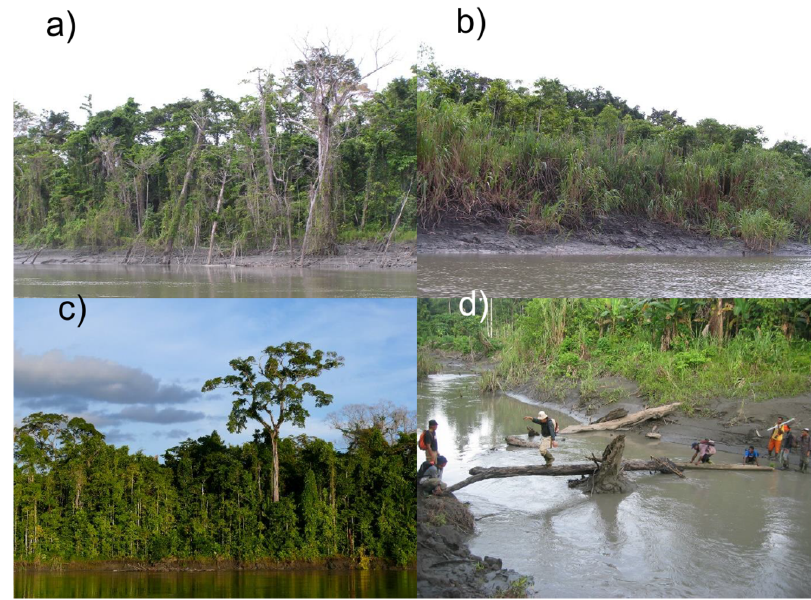
Figure 2. Riverside forests within the Mamberamo Basin are greatly impacted by the dynamic meandering that continually modifies the landscape, with some banks being rapidly eroded ( a ), while others grow as they accrue new sediments ( b ). Nonetheless, there are areas where the water flows more gently, and forest edges appear more stable ( c ). Within the landscape, there are many minor channels that drain the wider landscape and vary considerably in depth, depending on recent rainfall, and are often choked by fallen trees ( d ). Credits: DS, DS, MB, and